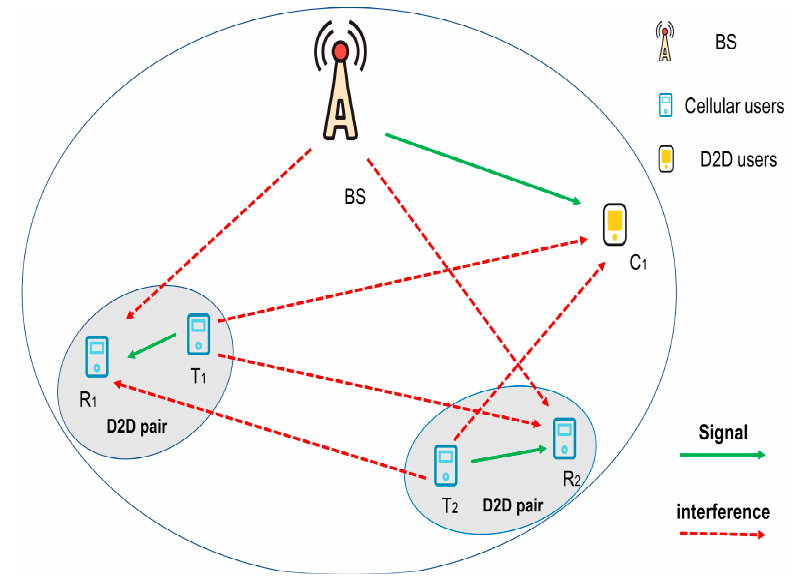
Figure 1. D2D communication system model.